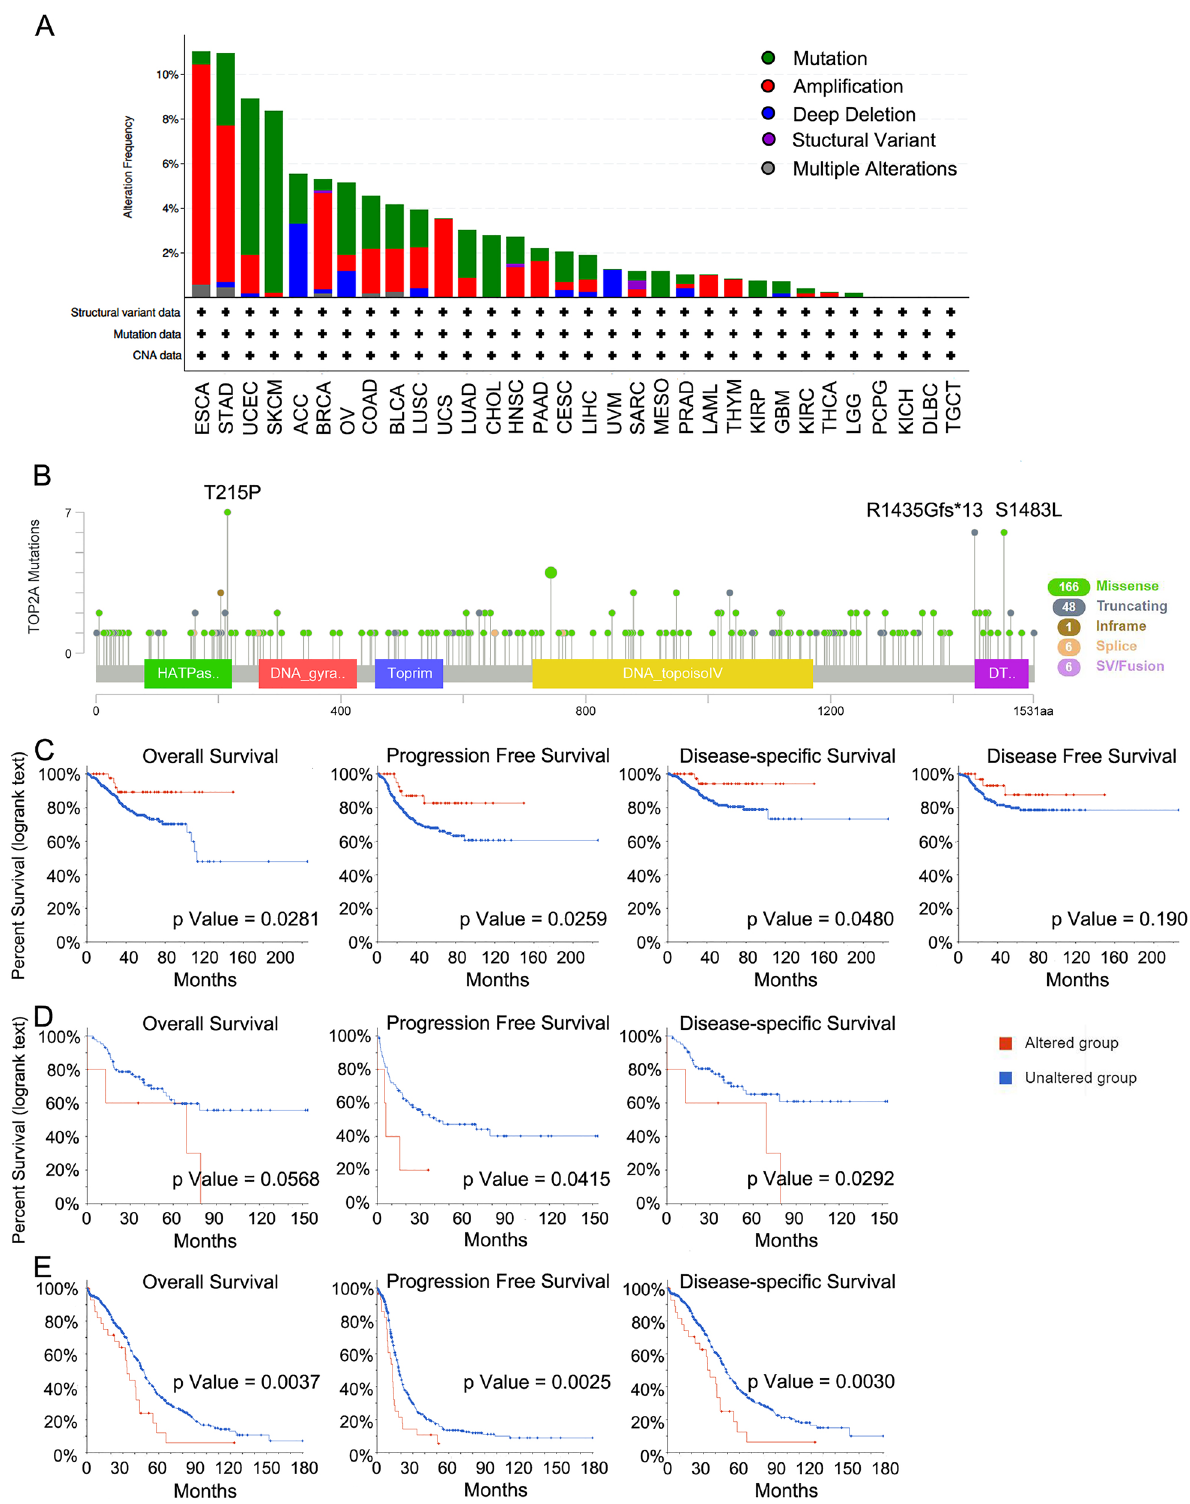
Figure 4. Genetic alteration analysis of TOP2A. ( A , B ) The alteration frequency with mutation type ( A ) and mutation site ( B ) in a pan-cancer analysis. ( C ) The correlation between TOP2A mutation status and overall, disease-specific, disease-free and progression-free survival in UCEC. ( D ) The correlation between TOP2A mutation status and overall, disease-specific, and progression-free survival in ACC. ( E ) The correlation between TOP2A mutation status and overall, disease-specific, and progression-free survival in